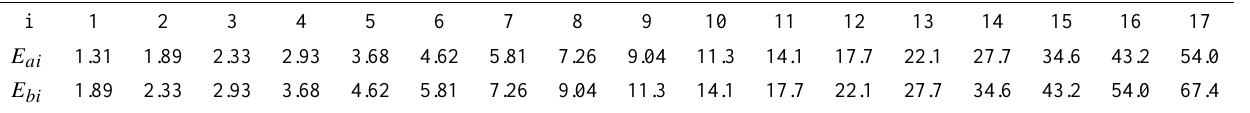
Table 2. Energy channels in eV